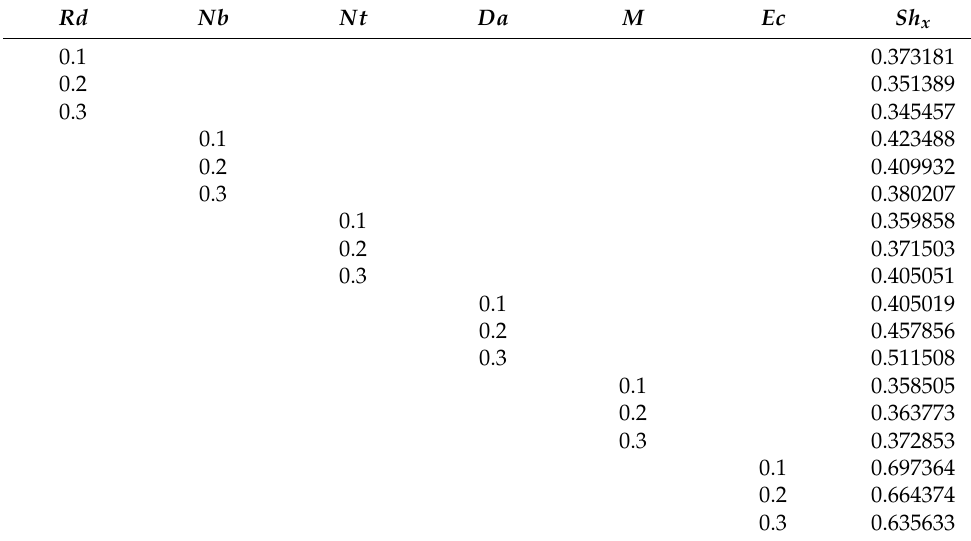
Table 4. Numerical values of Sherwood number via different embedded factors.